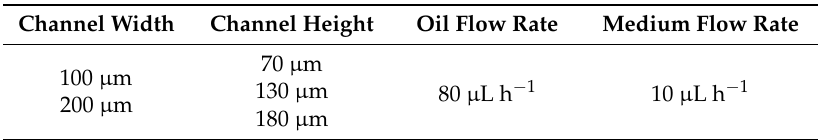
Table 5. Summary of fixed parameters for each channel dimension.